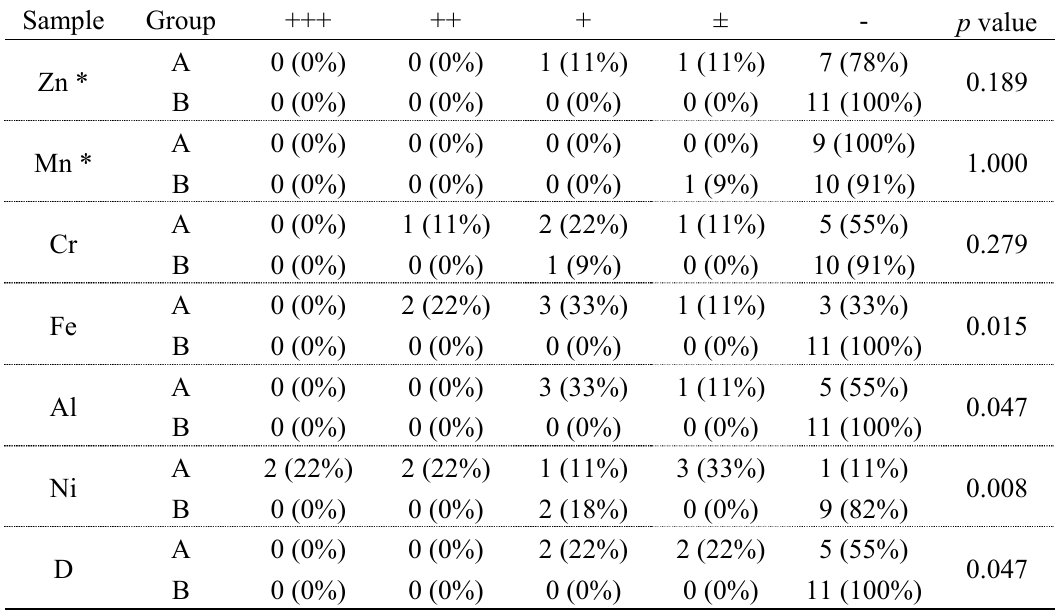
Table 2. The results of the patch tests and the percentages of each reaction. Chi-square test ( * Fisher’s exact test) with a significance level of 5%. Compared with group B, significantly more subjects in group A reacted to three metal sample preparations (Fe, Al, and Ni) and the Asian dust sample preparation (labeled as D on the y-axis).